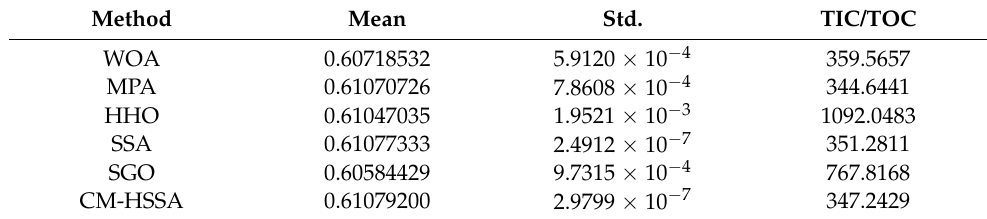
Figure 20. Iterative trajectories of six algorithms for Problem 1. Table 4. Comparison of optimization results for Problem